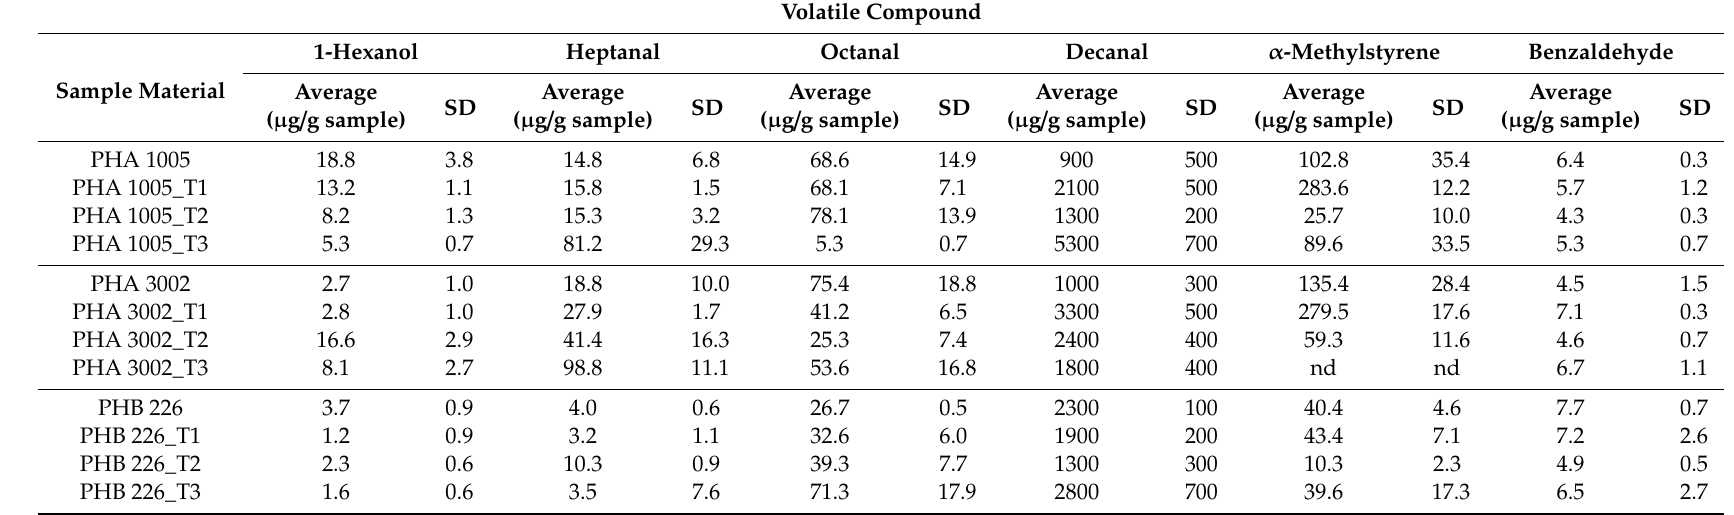
Table 4. Volatile compounds content for the PHB 226 PHA 1005 and PHA 3002 controls and the T1, T2 and T3 formulations, expressed as the mean ± SD (n =